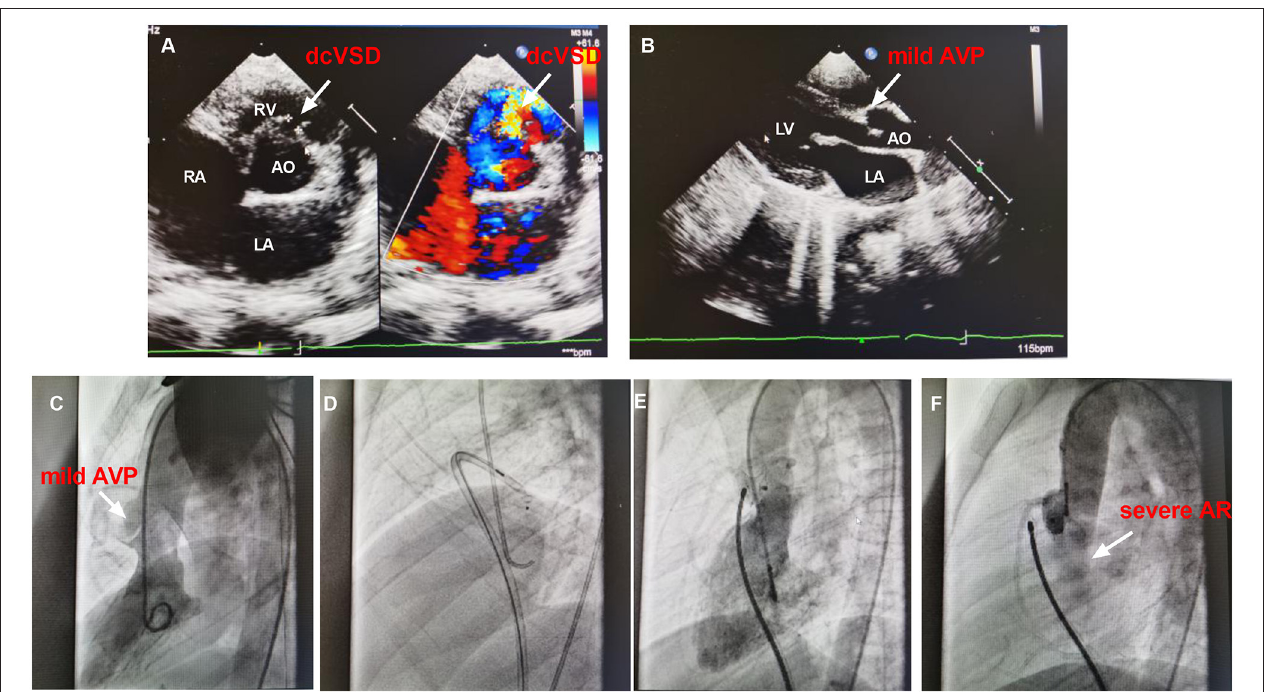
FIGURE 4 | The images of TTE and angiography of case 12. (A,B) shows the dcVSD and the mild AVP on TTE. (C) Shows the mild AVP by left ventricular angiography. (D) Demonstrates the closure using ADO-II and (E) Shows the closure with symmetrical double-disk occluder. (F) Shows the AR after deploying occluder. AO, aorta; AR, aortic regurgitation; AVP, aortic valve prolapse; dcVSD, doubly committed subarterial ventricular septal defect; LA, left atrium; LV, left ventricle; RA, right atrium; RV, right ventricle; TTE, transthoracic echocardiography.